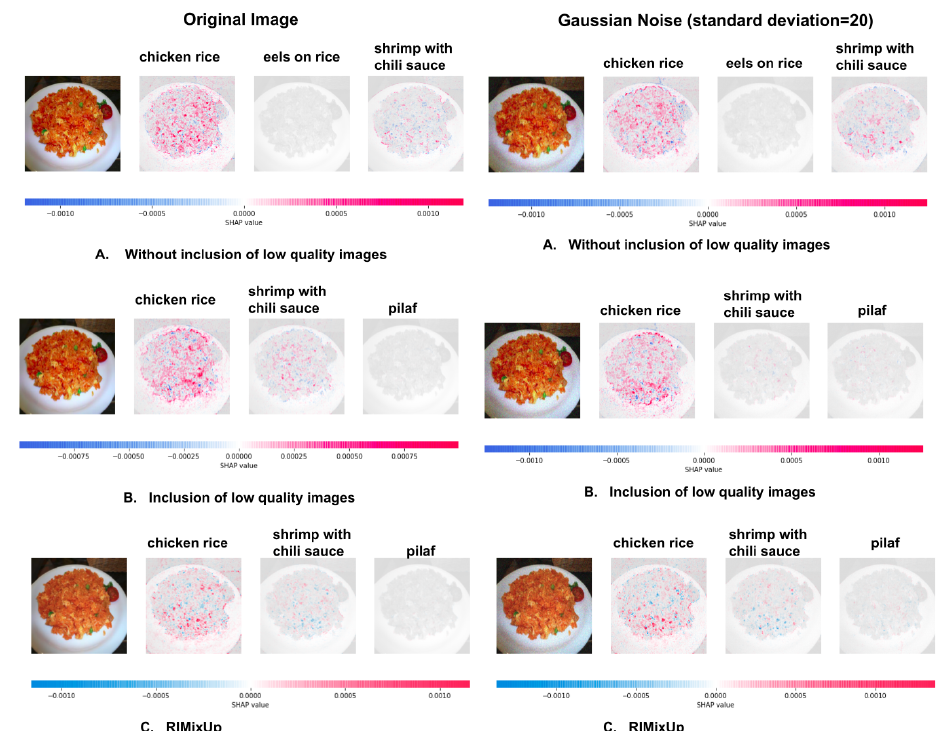
Figure 12. Visualization of pristine and food photo with Gaussian noise shows our method activates the relevant pixels for correct class.